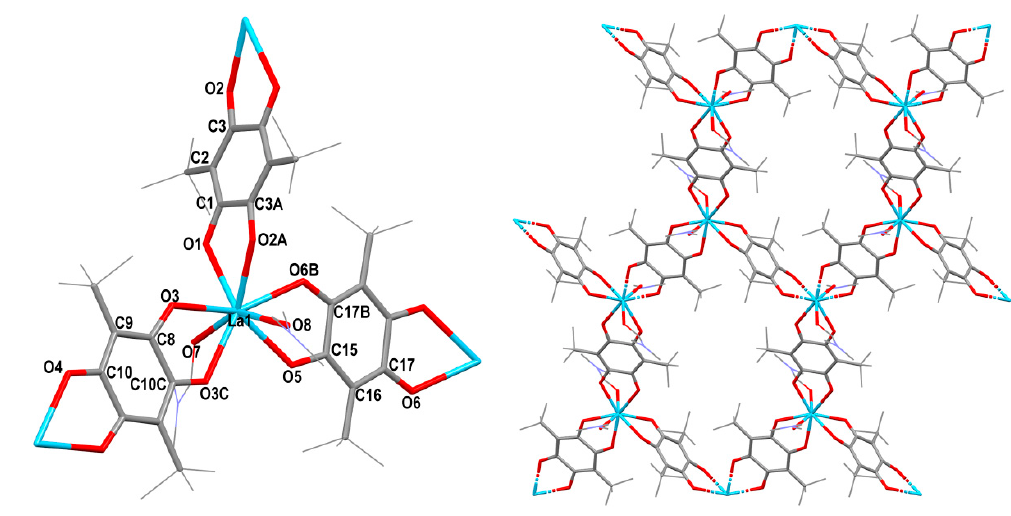
Figure 8. Molecular structure of binuclear unit of 4 (left); crystal structure of 4 along the (100) vector (right). Color code: La, light blue; C, gray; Cl, green; O, red; N, violet.